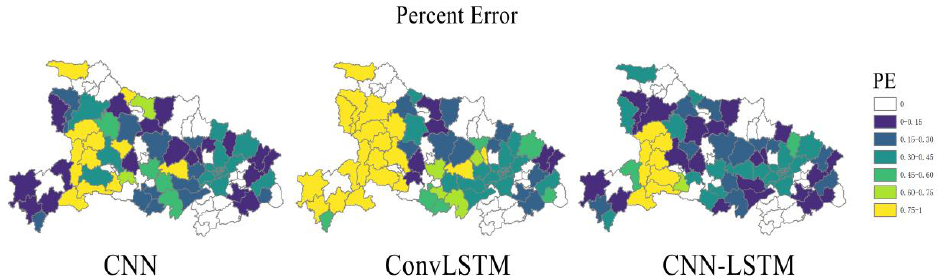
Figure 5. Percentage error map of the forecasts for 2019 for the three models.